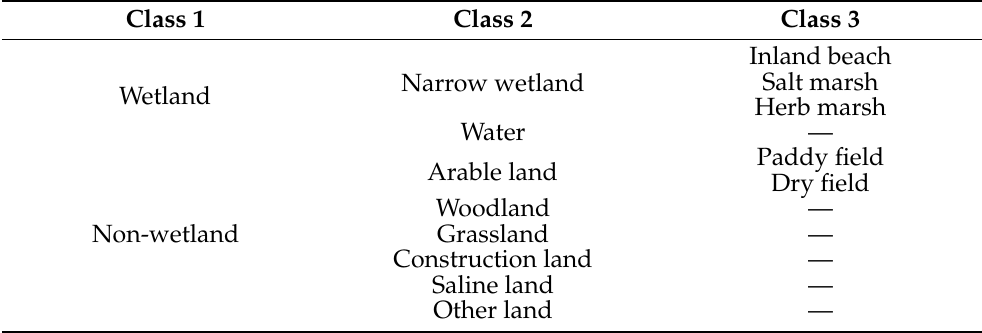
Table 2. The land classification system used in this study.